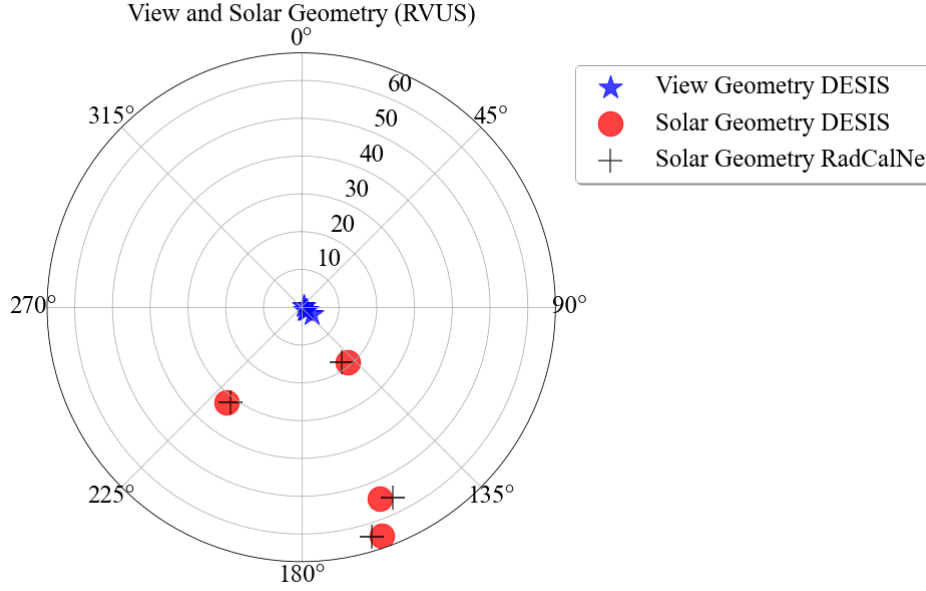
Figure 5. Acquisition geometry on RVUS. Blue symbols represent DESIS viewing geometry, red symbols represent DESIS solar geometry, and black symbols represent RadCalNet solar geometry.